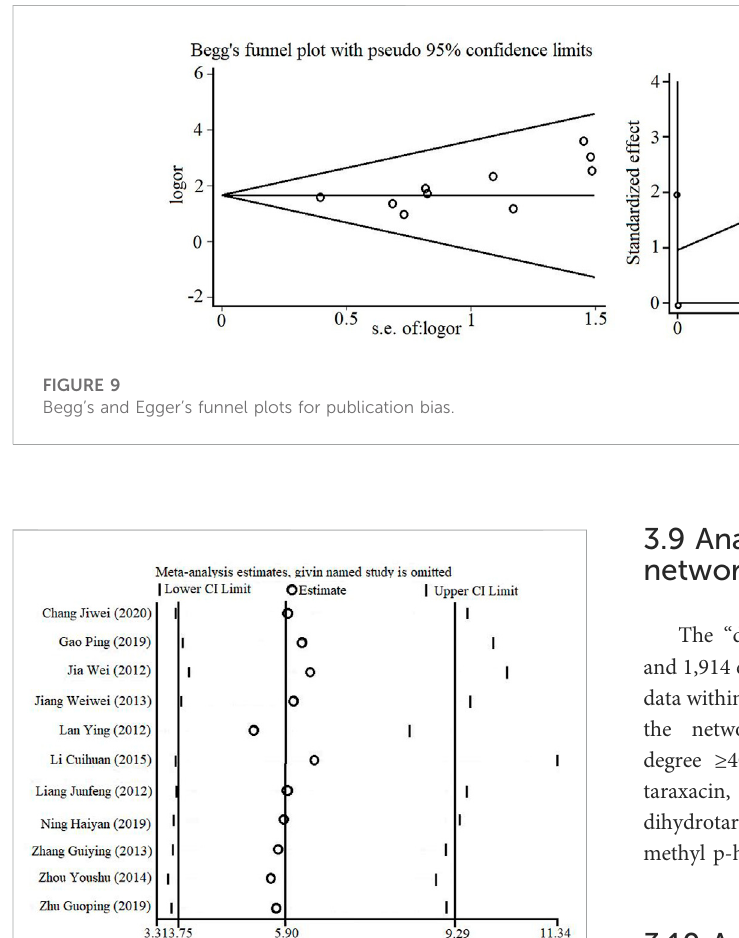
FIGURE 10 Results of sensitivity analysis.